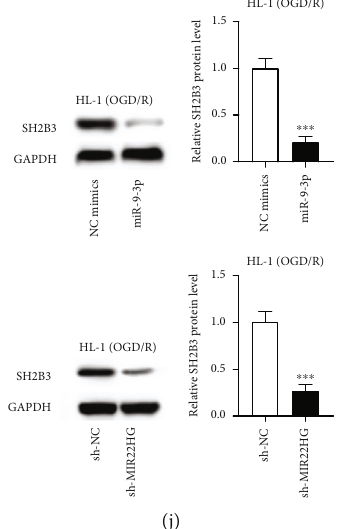
Figure 3: MIR22HG interacts with miR-9-3p to regulate SH2B3 expression. (a) The possible miRNAs that possibly bind to MIR22HG predicted in starBase. (b) The expression level of miR-9-3p and miR-298-5p in OGD/R-treated HL-1 cells was determined by RT-qPCR ( n = 3 ). (c) The overexpression e ffi ciency of miR-9-3p was evaluated by RT-qPCR ( n = 3 ). (d and e) The binding sequence between miR- 9-3p and MIR22HG is shown. Luciferase reporter assay was used to con fi rm the binding capacity between miR-9-3p and MIR22HG ( n = 3 ). (f) The expression level of candidate target mRNAs in OGD/R-treated HL-1 cells was determined by RT-qPCR ( n = 3 ). (g) The binding sequence between miR-9-3p and SH2B3 3 ′ UTR. (h) Luciferase reporter assay was used to validate the binding between miR-9- 3p and SH2B3 3 ′ UTR ( n = 3 ). (i and j) The mRNA and protein levels of SH2B3 in the context of miR-9-3p overexpression or MIR22HG knockdown were measured by RT-qPCR and western blotting analyses ( n = 3 ). ∗ p < 0 : 05 , ∗∗ p < 0 : 01 , ∗∗∗ p < 0 : 001